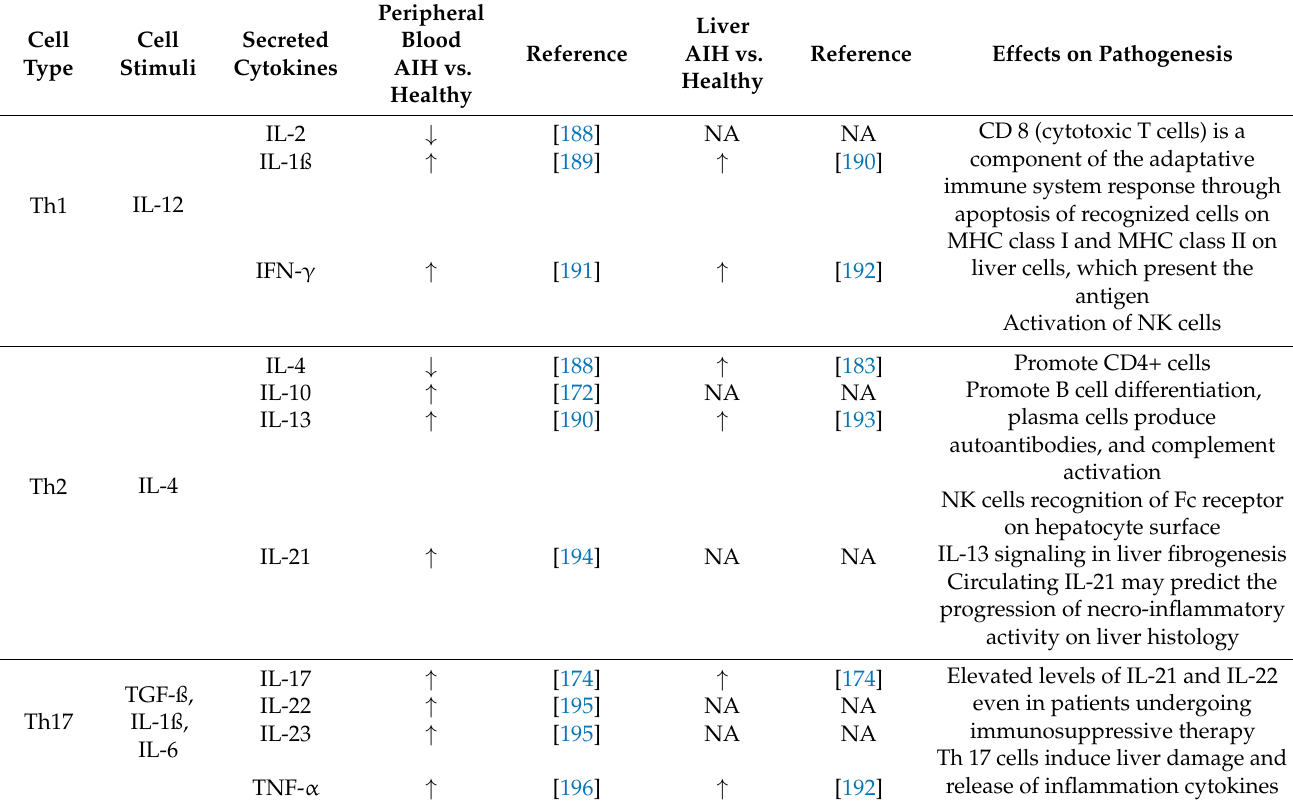
Table 4. Key inflammatory perturbations in autoimmune